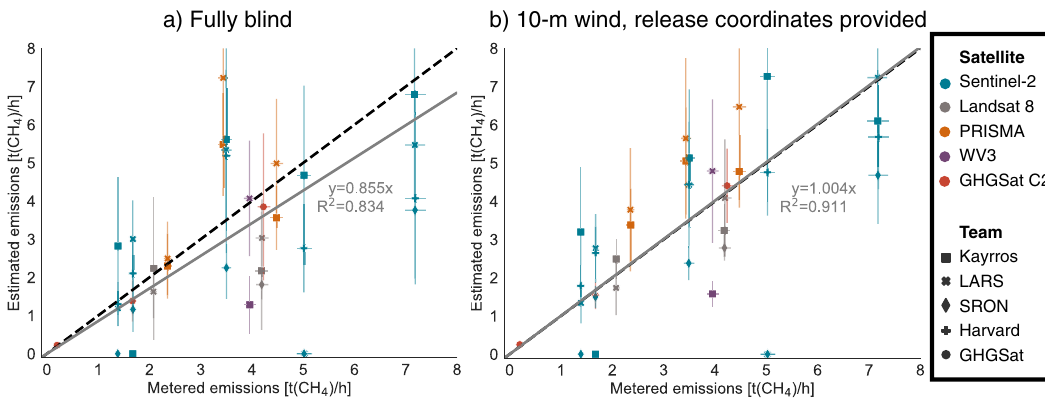
Figure 3. Quantification performance of methane emissions estimates by satellite and team. Metered emissions compared with single-blind estimates for each overpass with successfully reported data, with 1-sigma X and Y error bars. ( a ) Fully blind stage 1 results using modeled wind speed estimates. ( b ) Stage 2 results using 10-m wind speed and direction measurements and the point source location of the plume. Percent error in both cases is similar to aircraft-based methane remote sensing methods. The grey solid line is a linear fit with the intercept fixed at zero, with slope and uncentered R 2 displayed. The black dashed lines denote exact 1:1